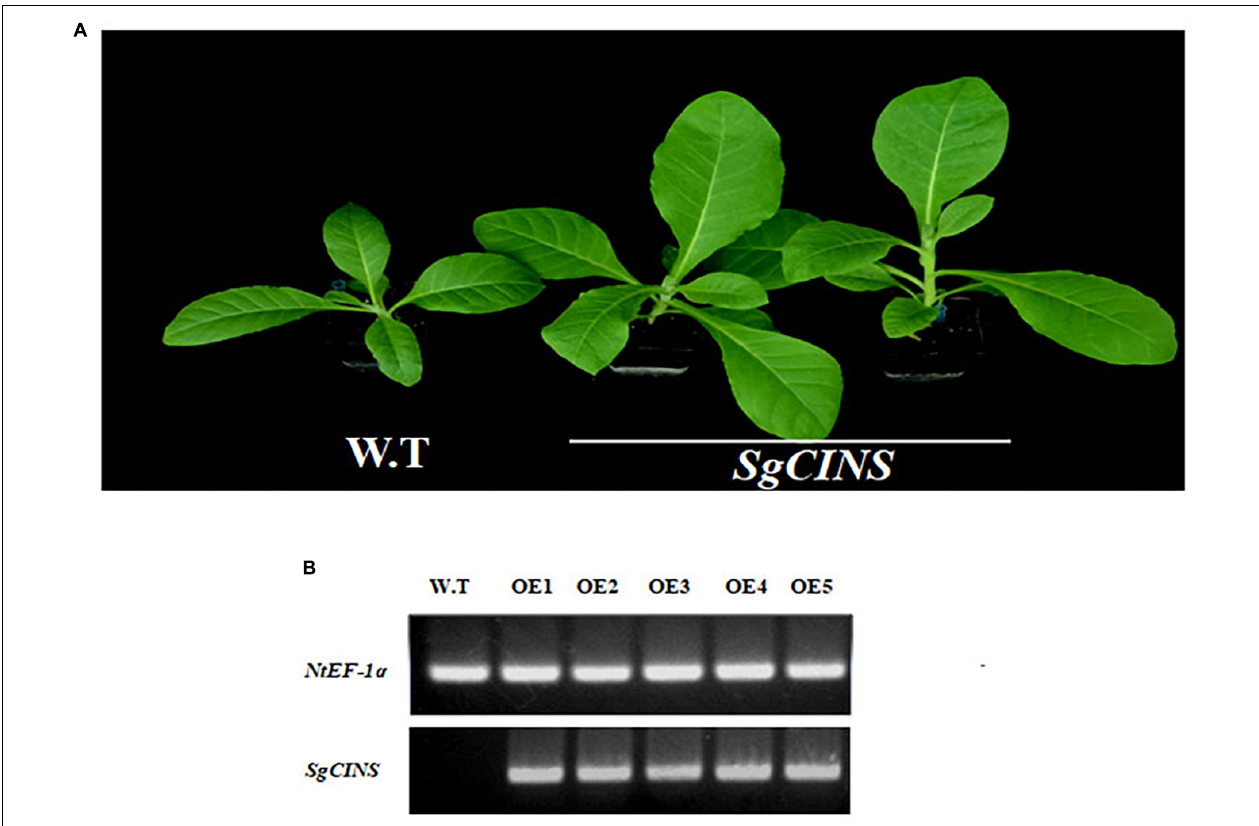
FIGURE 4 | Overexpression of S. guaranitica SgCINS gene in transgenic tobacco. (A) Comparison of the phenotypes of the transgenic N. tabacum and wild-type N. tabacum . (B) Semiquantitative RT-PCR to confirm the expression of SgCINS